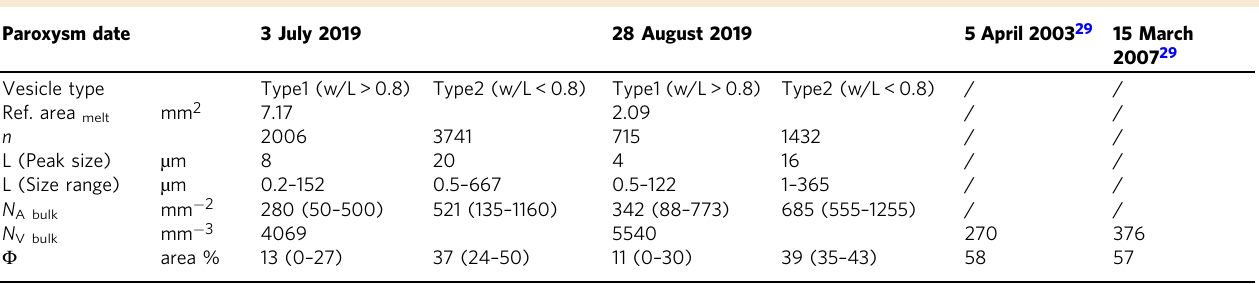
Table 2 Vesicularity data in LP magma for the 2019 paroxysmal